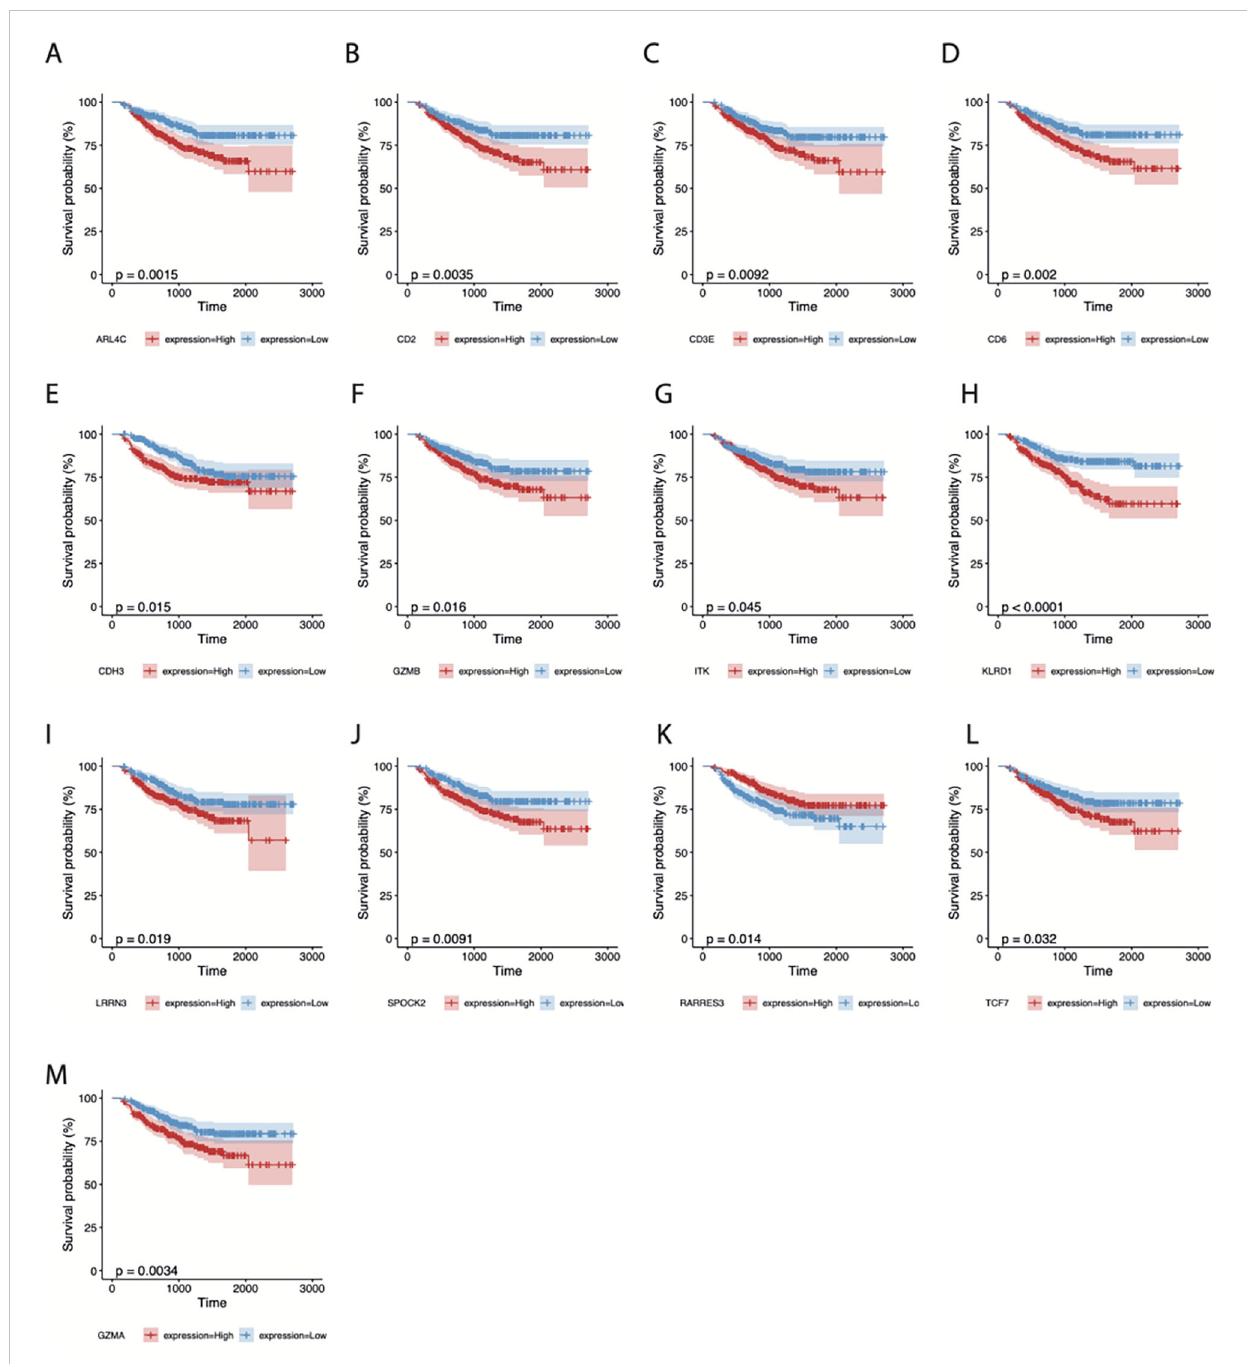
FIGURE 5 Survival analysis of 13 CD8T-speci fi c high-expression genes. DRFS effects of ARL4C (A) , CD2 (B) , CD3E (C) , CD6 (D) , CDH3 (E) , GZMB (F) , ITK (G) , KLRD1 (H) , LRRN3 (I) , SPOCK2 (J) , RARRES3 (K) , TCF7 (L) , and GZMA (M)